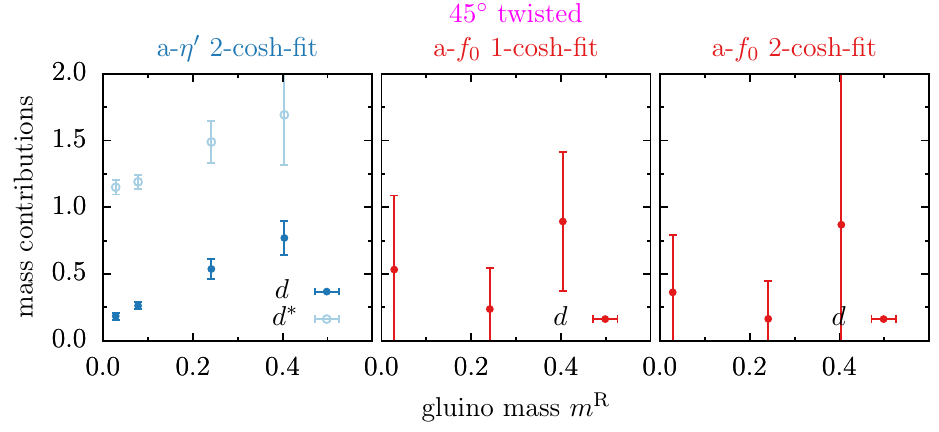
Figure 10 . Masses for a- f 0 and a- η 0 from a 16 3 × 32 lattice at β = 5 . 0 and for a twist angle α = 45 ◦ . Results are shown as a function of the renormalized gluino mass m R . Left: lowest d and next higher mass contribution d ∗ of a- η 0 extracted by a 2-cosh-fit. Center/Right: lowest contribution d of a- f 0 extracted by a 1-cosh-fit/2-cosh-fit. Two resp. four time slices are excluded in the correlator fit at the boundary resp. around the inner time slice, i.e., t cut = (2 , 4)